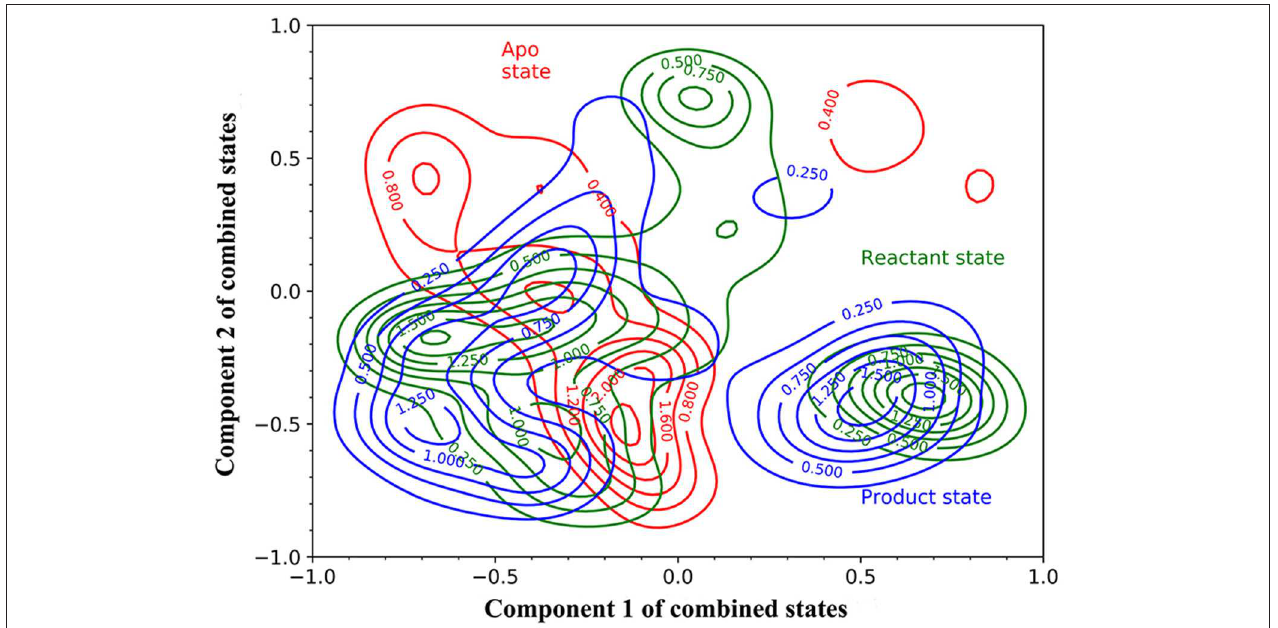
FIGURE 4 | The projection of the simulations of TEM-1 in apo (red), reactant (green) and, product (blue) states onto Component 1 and Component 2 of combined states. Components 1 and 2 are the first and second components from the principal component analysis (PCA) based on the simulations of all three states. The projection on to components 1 and 2 are